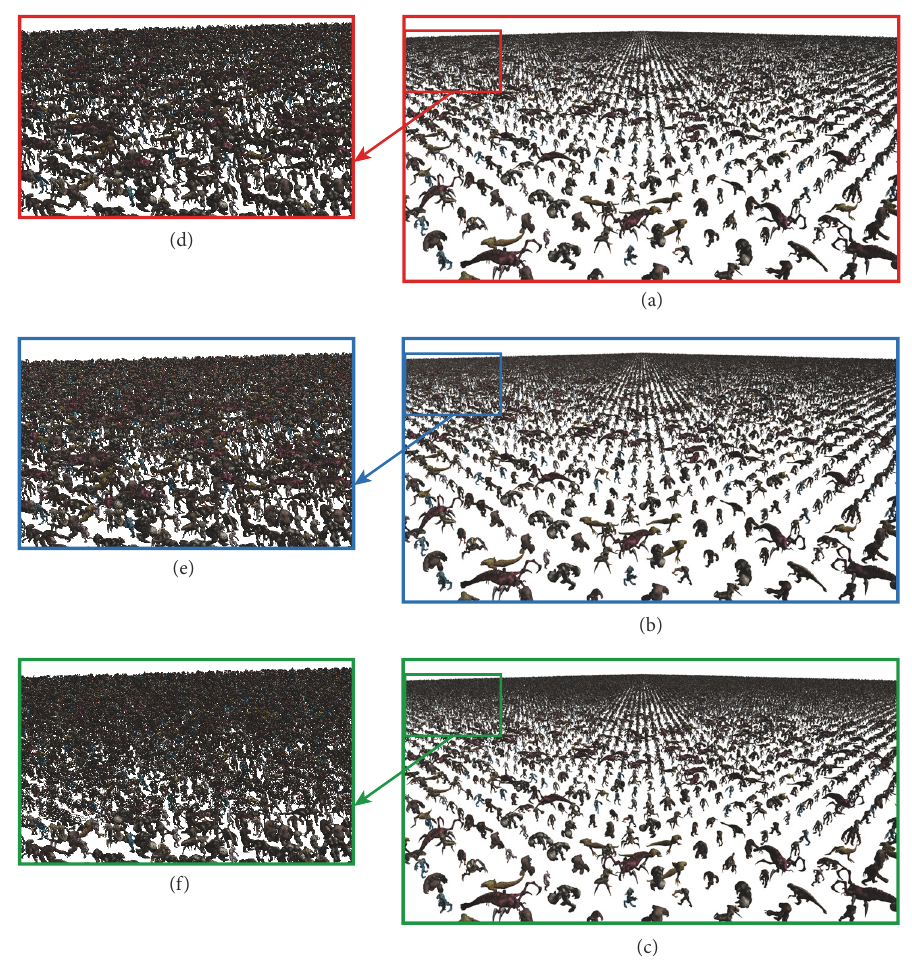
Figure 8: The visual quality comparison of our approach, pseudo-instancing technique, and point-based technique.The number of rendered instances on the screen is 20000. (a) shows the captured image of our approach rendering result with 𝑁 = 5 million. (b) shows the captured image of pseudo-instancing technique rendering result. (c) shows the captured image of the point-based technique rendering result. (d), (e), and (f) are the captured images zoomed in on the area of instances which are far away from the